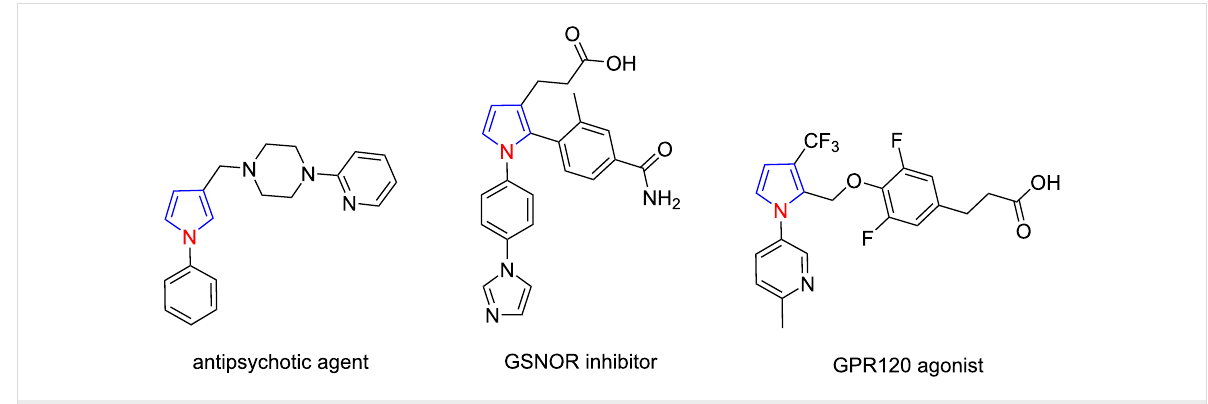
Figure 1: Representative biologically active N -(hetero)aryl-4,5-unsubstituted pyrrole